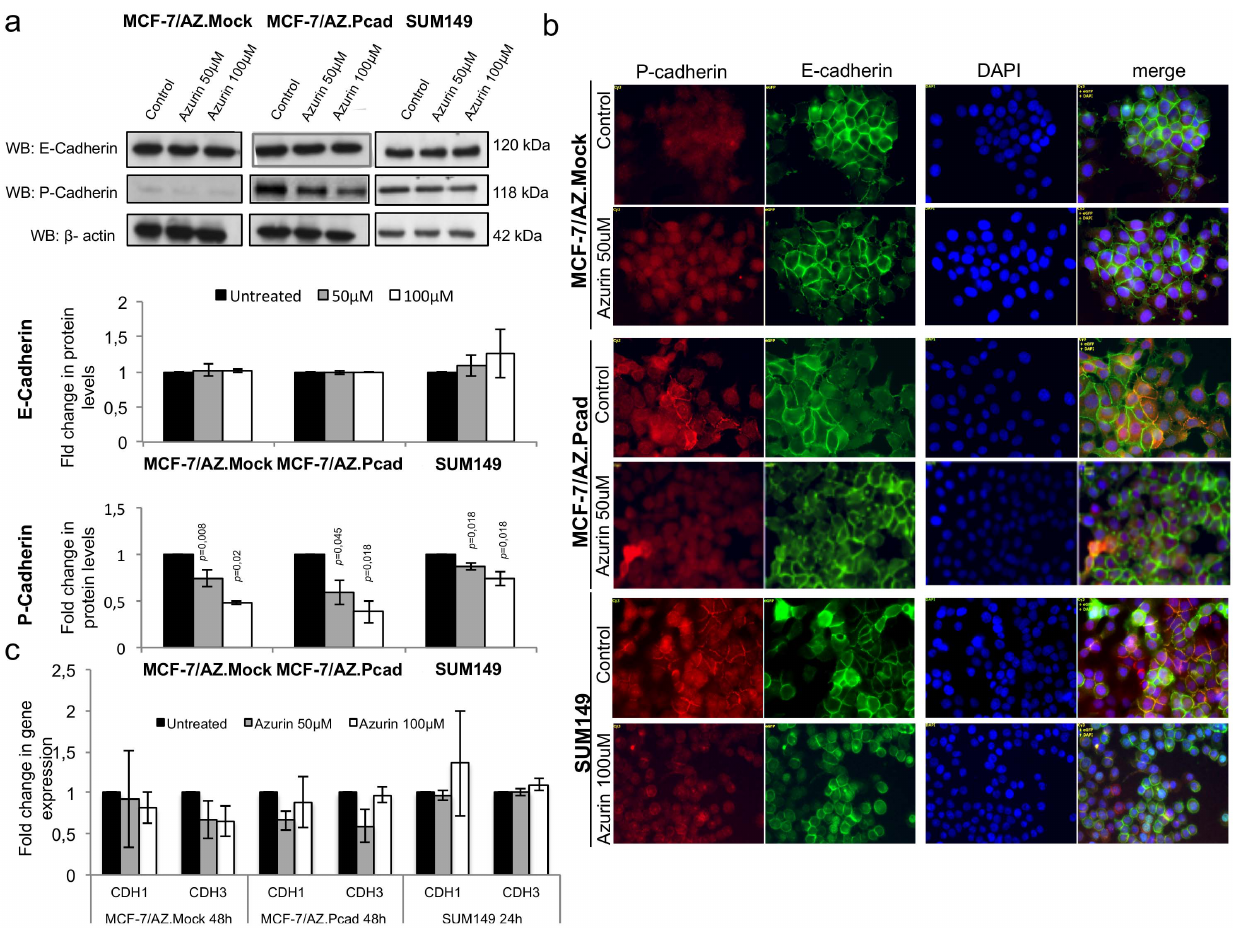
Figure 2. Azurin decreases P-cadherin protein levels. a) One single treatment with azurin at 50 m M and 100 m M for 48 h (MCF-7/AZ.Pcad) and 24 h (SUM149) (to match the time course of invasion assays) reduces the P-cadherin expression by Western Blot with no significant alteration at E- cadherin levels. Results are presented as the ratio of band intensity of target protein between azurin treated samples and control samples, both normalized to their respective actin band intensity b) Same results were observed by immunofluorescence analysis of both cadherins in the same treatment conditions. c) Azurin does not significantly change the expression levels of CDH1 /E-cadherin or CDH3 /P-cadherin at mRNA levels, as observed by qRT-PCR at the same conditions as for Westerm Blot